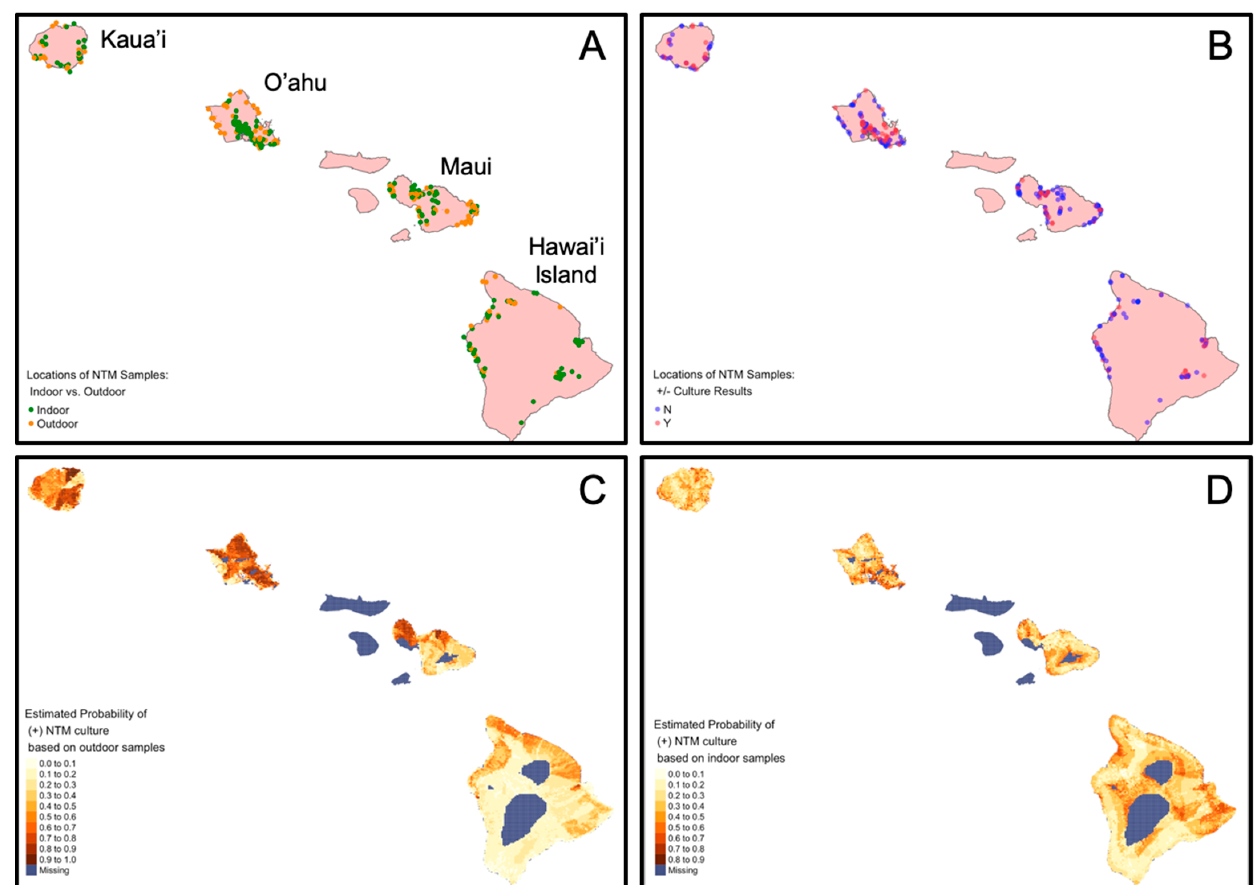
Figure 2. Sample locations stratified by outdoor and indoor locations, NTM microbiological culture results, and probability of NTM detection based on predictive models. The same sampled sites are shown on each map representing all sample locations for this study, which were also used in predictive modeling. ( A ) Map identifies the samples collected from outdoor (orange) or indoor (green) sources. ( B ) Map identifies the sample locations that were NTM culture-positive (“Y, red dots) or NTM culture-negative (“N”, blue dots). Dark dots indicate locations where sample collection sites overlap. Map ( C ) indicates the probability of NTM in outdoor locations based on 134 outdoor samples. Accuracy estimate: 0.70. Map ( D ) indicates the probability of NTM in indoor locations based on 216 indoor samples. Accuracy estimate: 0.56.